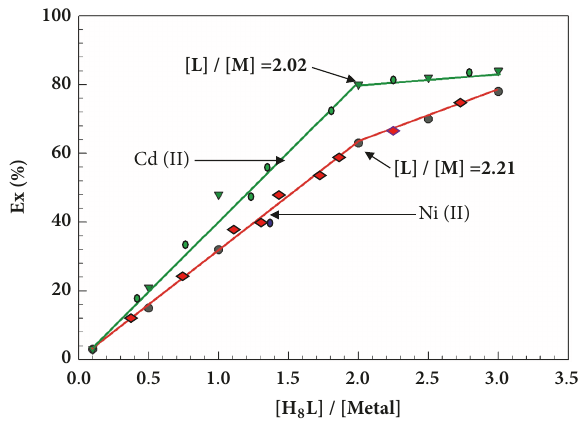
Figure 6: Plots of percentage extraction vs. molar ratio [L]/[M] for the extraction of Cd 2+ and Ni 3+ with H 8 L under the same reaction condition of Figure 3. O:A = 1:1. Symbol (empty green inverted triangle), (filled green circle) (repeated) (filled red diamond) (filled red circle) (repeated)-H 8 L; O/A = 1; T = 25 ∘